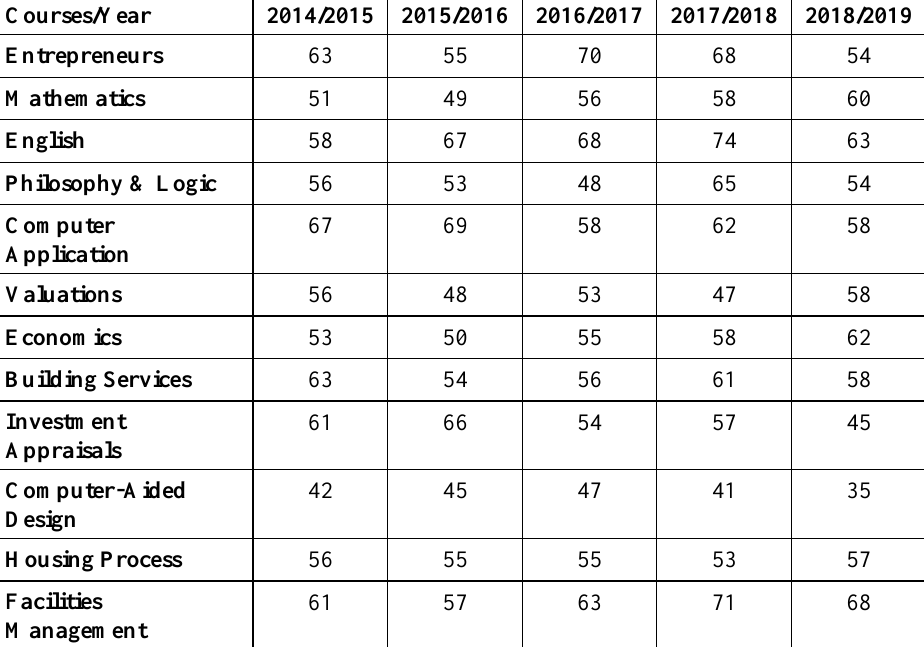
Table 6. The Mean Scores of the Students (%) (developed by the authors)